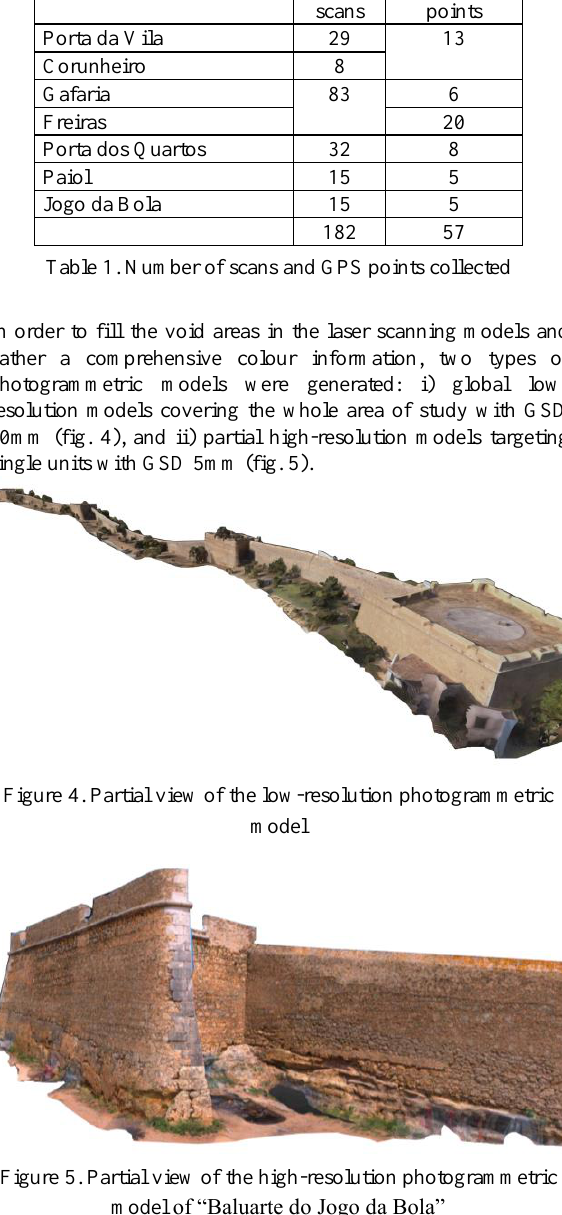
Figure 5. Partial view of the high-resolution photogrammetric model of “Baluarte do Jogo da